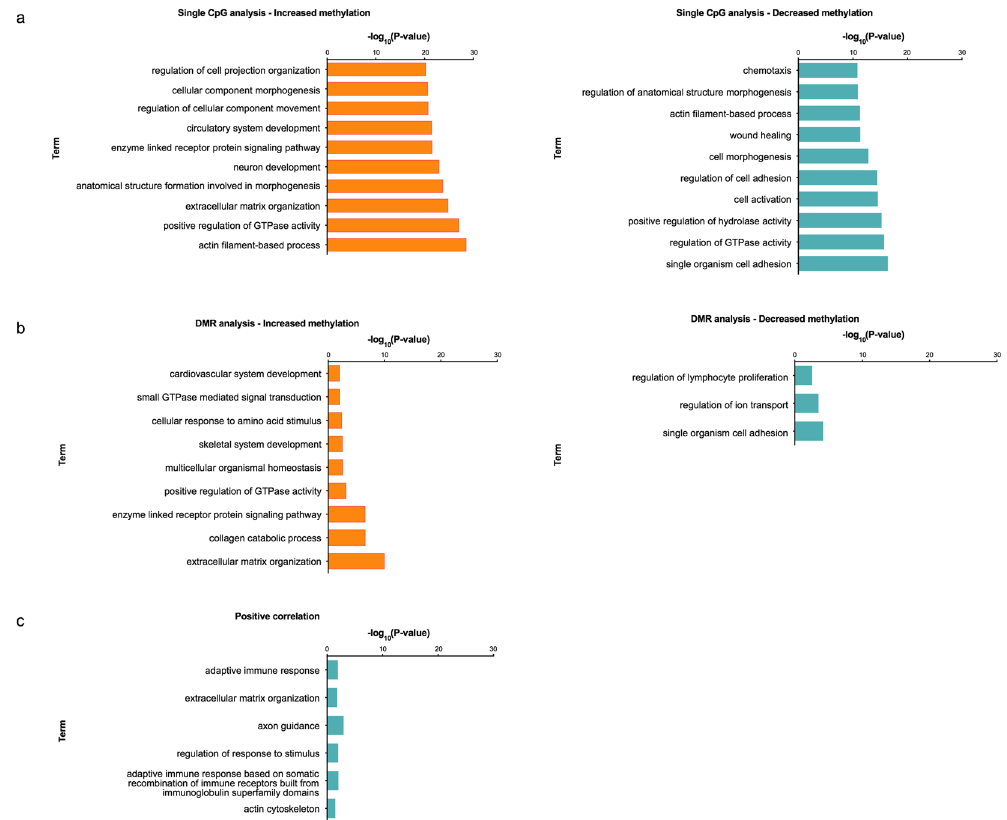
Figure 5. Pathway analysis of genes mapped to significantly differentially methylated sites. ( a ) CpG-level analyses. ‘Increased’ and ‘decreased’ methylation stand for methylation status in receptive endometrium relative to pre-receptive endometrium; ( b ) Region-level (DMR) analyses. ‘Increased’ and ‘decreased’ methylation stand for methylation status in receptive endometrium relative to pre-receptive endometrium; ( c ) For genes showing positive correlation between gene expression and methylation. No enrichment for biological terms was seen among negative correlations. The barplot shows the –log10 (p-values) for most significantly enriched pathways and GO terms. For full lists, please see Supplementary Tables